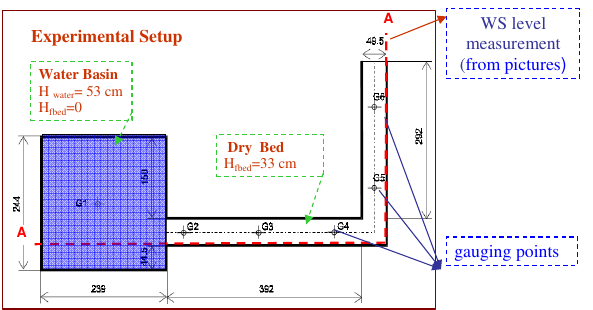
Fig. 14. Experimental set-up and initial conditions for the dam break over a 90 ◦ bend test case, all dimensions in cm. Gauging points G1, G2, G3, G4, G5 and G6 (Soarez et al., 2002.)